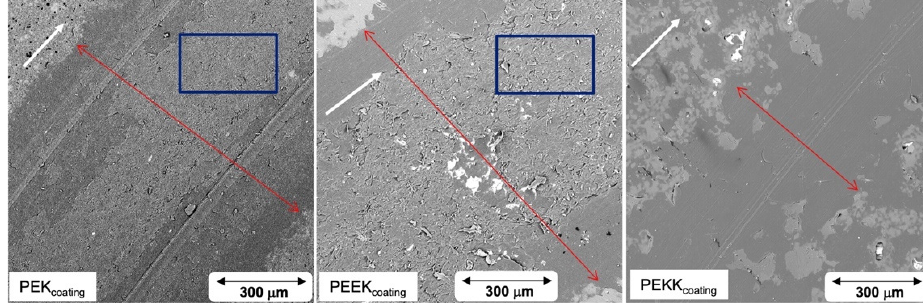
Figure 17. SEM images of the wear track of each coating in backscattered